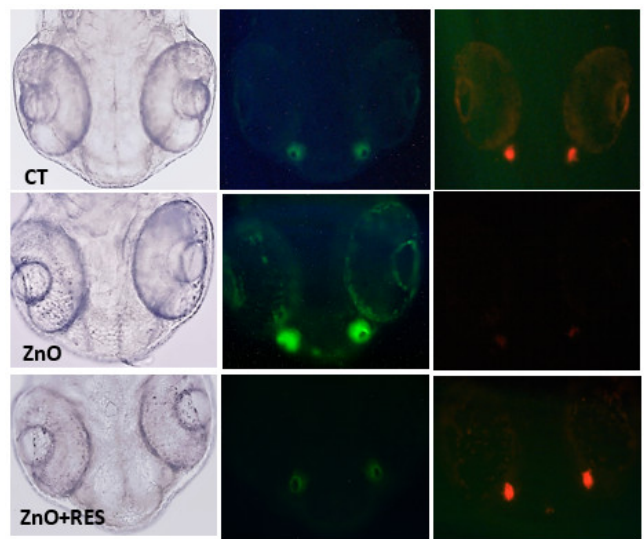
Figure 5. Resveratrol decreases mitochondrial damage induced by ZnO NPs. Qualitative analysis in 72-hpf zebrafish embryos after 5.0 μM JC-1 staining. Fluorescent microscopy images show mitochondrial membrane potential (ΔΨm) in untreated embryos (CT), 3 mg/L ZnO-treated embryos (ZnO NP), and embryos treated with 3 mg/L ZnO in the presence of 5 μM resveratrol (ZnO + RES). Red fluorescence, a sign of preserved ΔΨm, is clearly visible in both non-treated embryos and embryos treated with the addition of RES, whereas embryos treated with ZnO NP display a low red signal, along with a bright green fluorescent signal, index of mitochondrial membrane depolarization. RES, resveratrol. Magnification 20×.